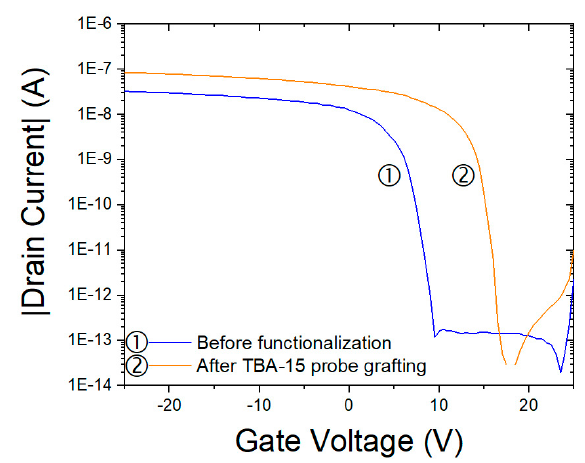
Figure 6. Transfer characteristics obtained for an L = 100 µm, W = 100 µm NN–FET at a drain voltage of V ds = − 2 V. The device was located in the quarter Q2 (see Figure 1): 1 (cid:79) before biofunctionalization process and 2 (cid:79) after TBA–15 probe grafting.